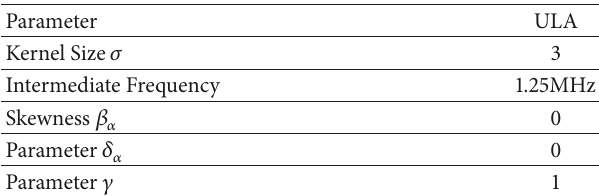
Table 2: Parameter values for